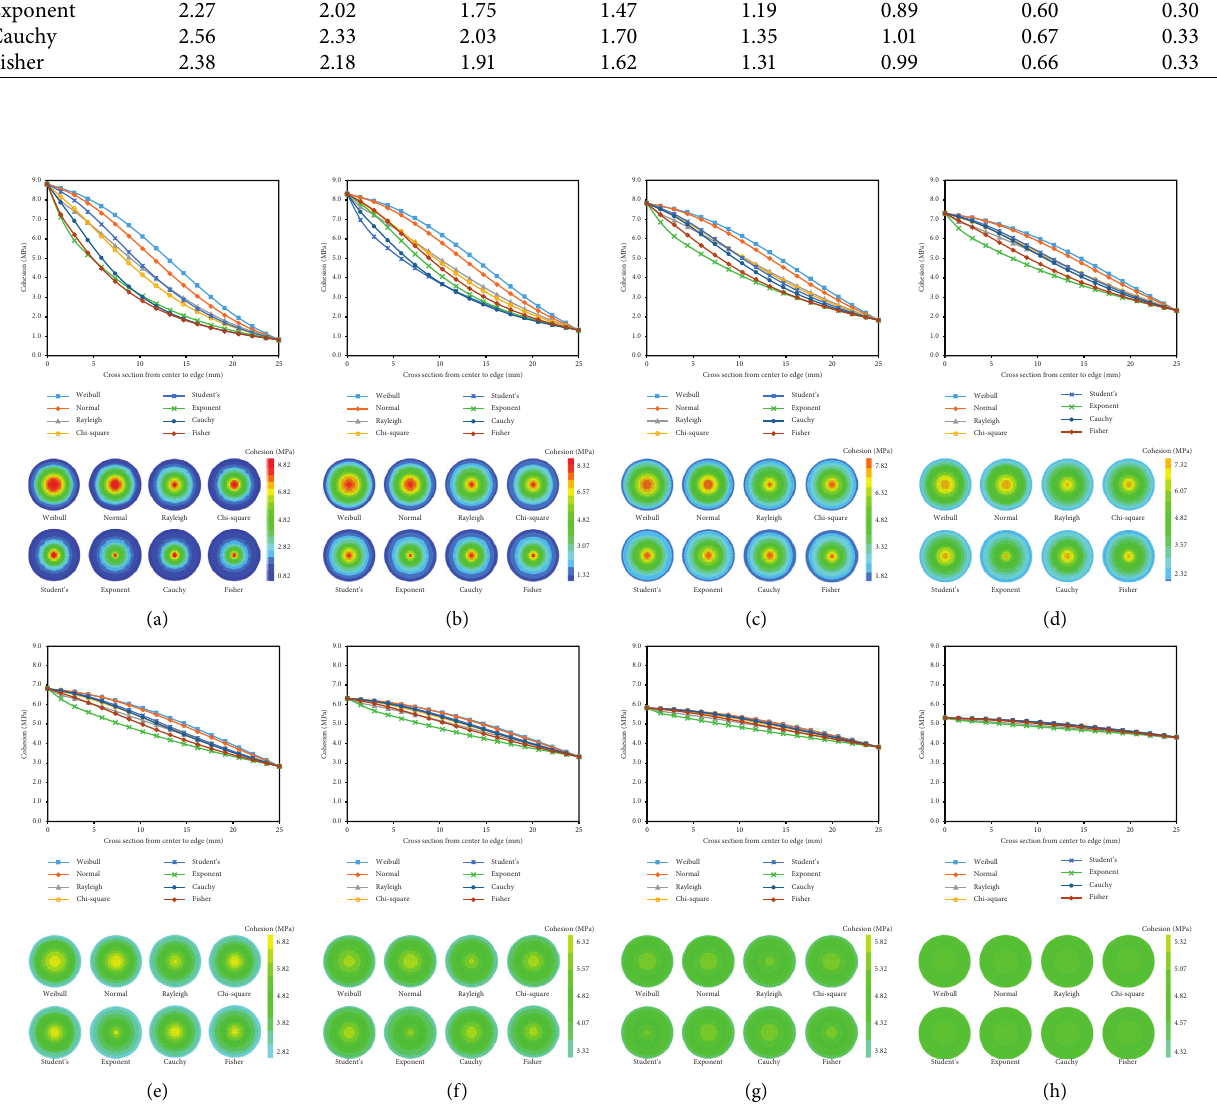
Figure 8: Nonuniform cohesion assignment results in coal specimen under eight cohesion scatter intervals: (a) cohesion interval of 0.82–8.82MPa, (b) cohesion interval of 1.32–8.32 MPa, (c) cohesion interval of 1.82–7.82 MPa, (d) cohesion interval of 2.32–7.32MPa, (e) cohesion interval of 2.82–6.82MPa, (f) cohesion interval of 3.32–6.32MPa, (g) cohesion interval of 3.82–5.82MPa, and (h) cohesion interval of 4.32–5.32 MPa.